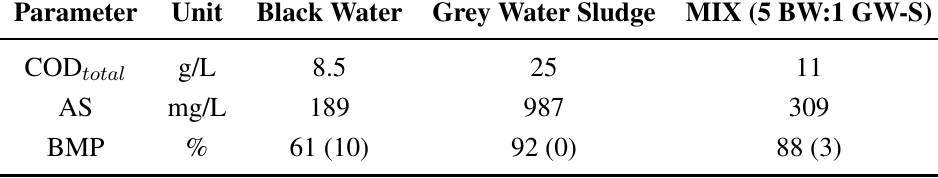
Table A1. Sample composition and biochemical methane potential (BMP) in the batch experiments.